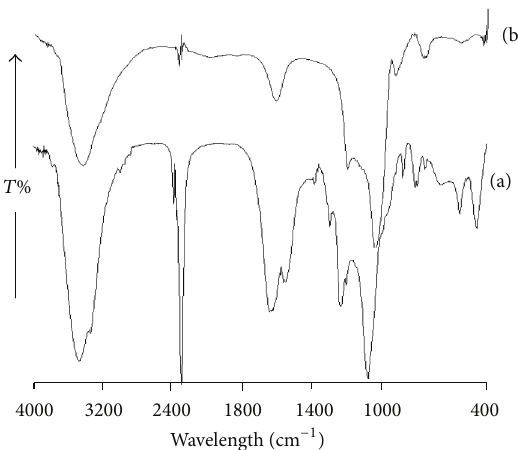
Figure 2: Fourier transform infrared spectroscopy (FTIR) spectra of MCM-PS-TDI (a) and MCM-41 (b).